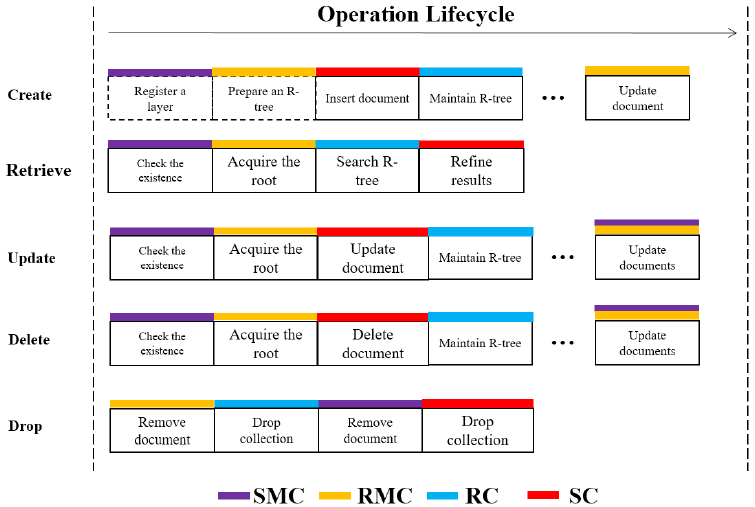
Figure 6. Execution logic for R-tree-related operations.